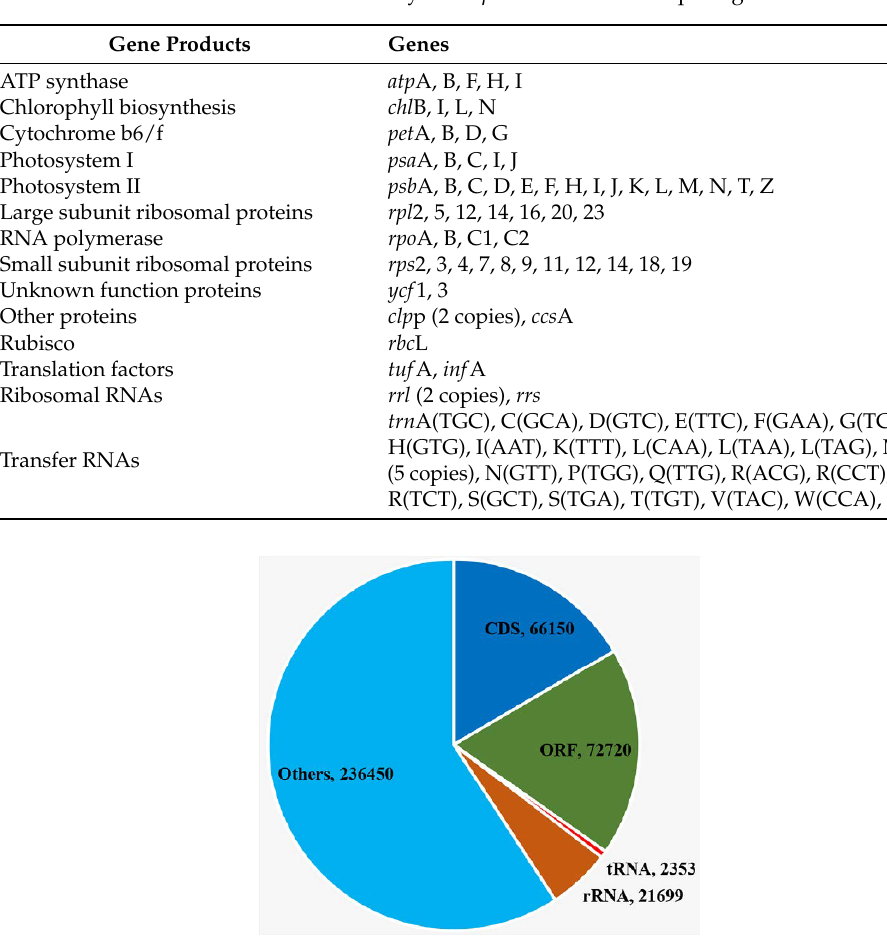
Figure 6. The size of CDS (protein coding regions), ORF (open reading frames, >100 aa), tRNA, rRNA